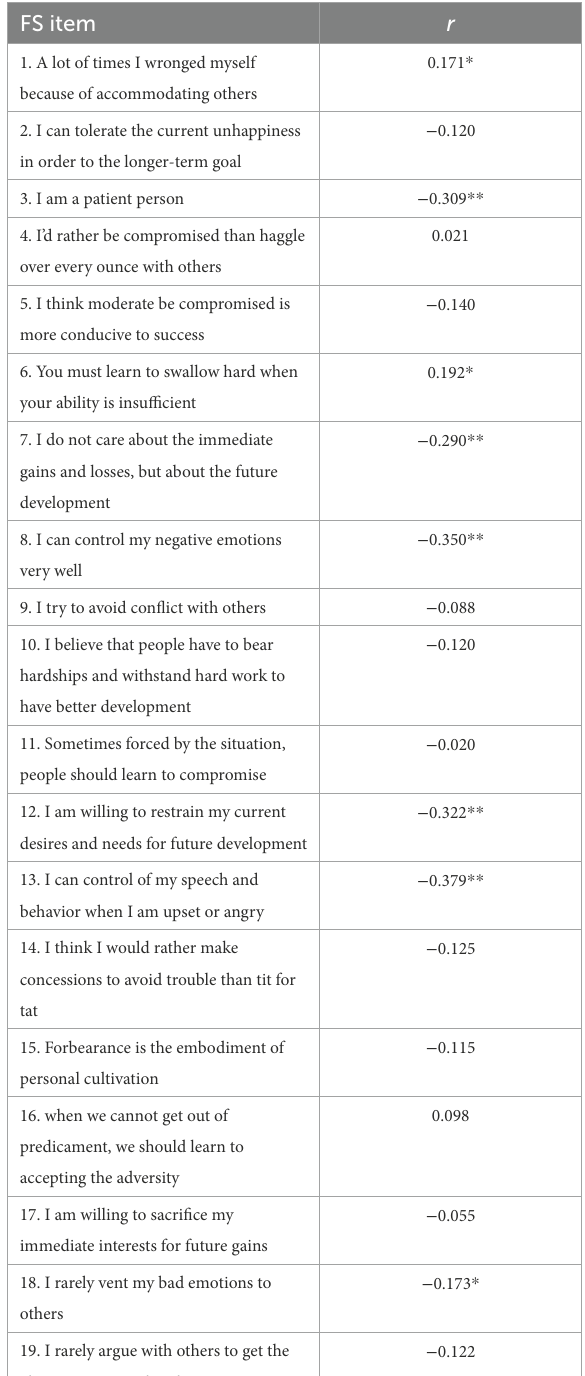
TABLE 2 Correlations between FS and